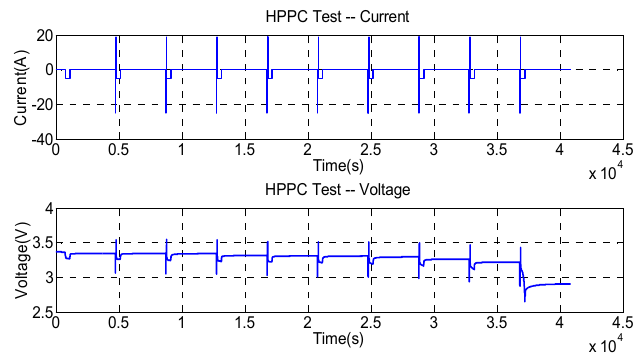
Figure 3. The hybrid pulse power characterization (HPPC) profile.